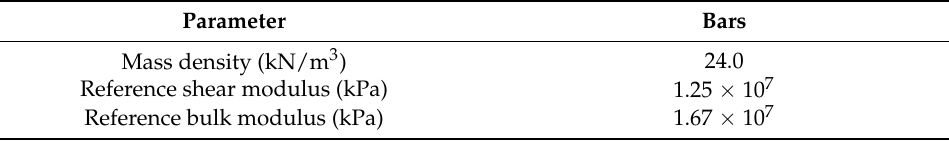
Table 7. Foundation